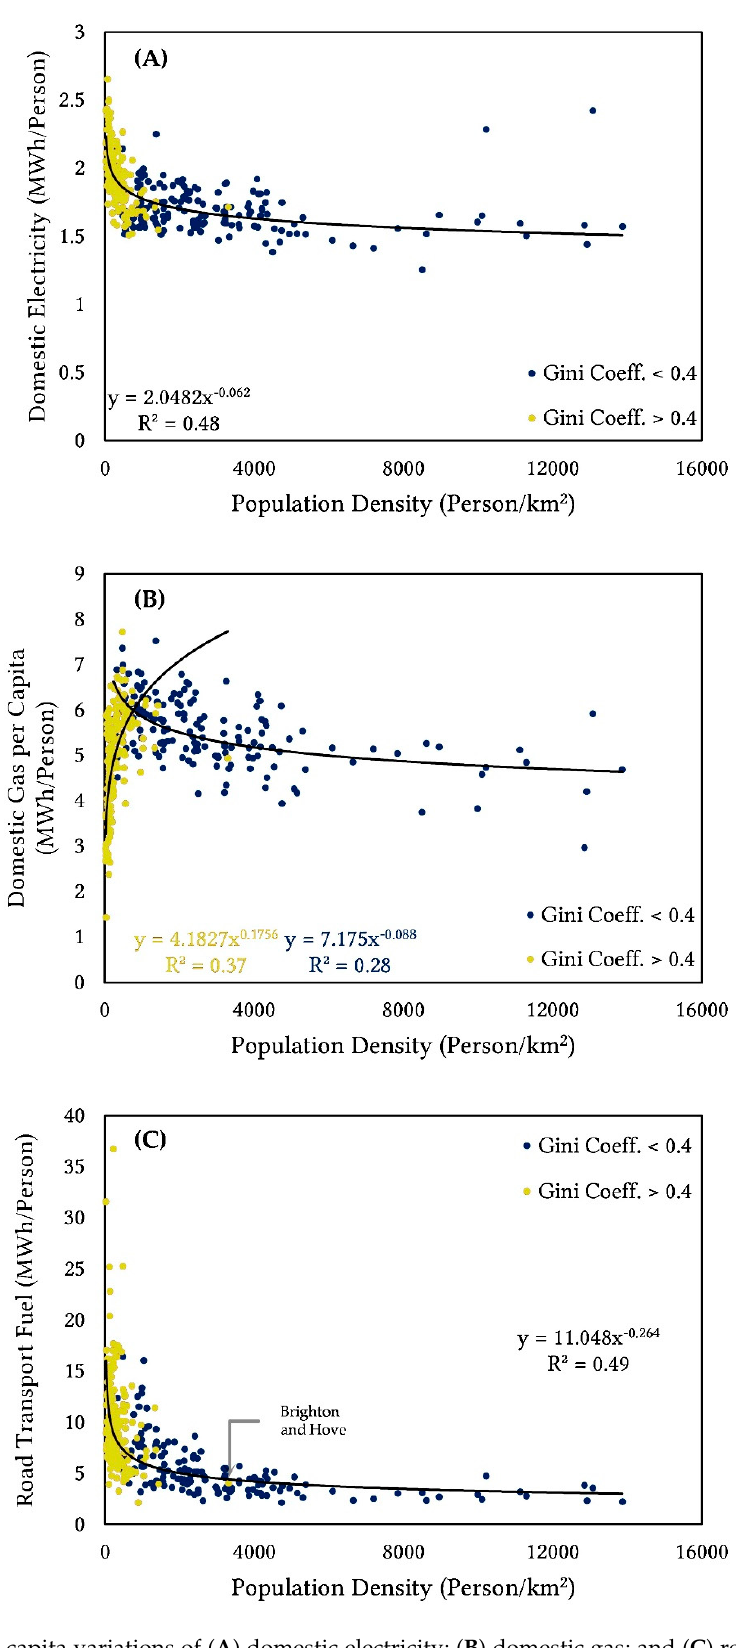
Figure 4. Per capita variations of ( A ) domestic electricity; ( B ) domestic gas; and ( C ) road transport petroluem fuel with population density (urban and rural LAUs have been denoted by blue and yellow, respectively).